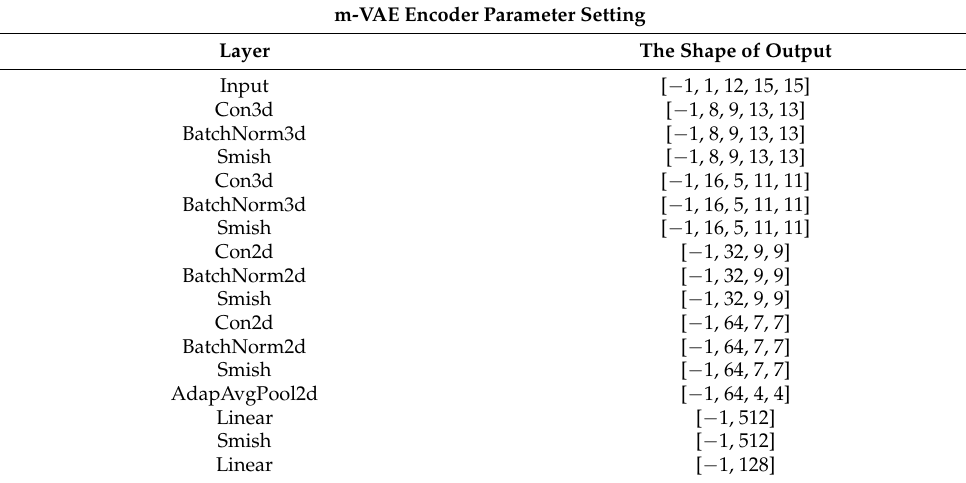
Table 8. The shape of layers in the m-VAE model for decoding.